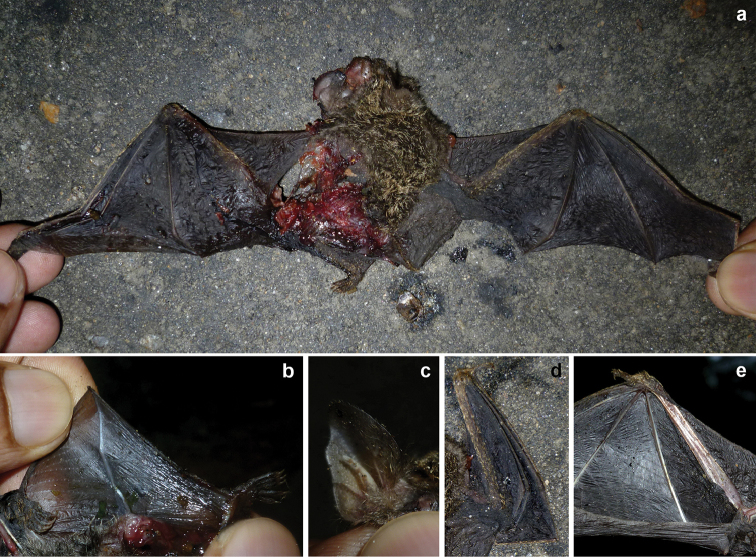
Road killed specimen of Phoniscuscf.jagorii with key characters a wingspan with the dorsal body color b Interfemoral membrane is well developed and semi–transparent (parts of the interfemoral membrane was damaged) c Long, tapering, notched tragus d forearm and digits covered with short, golden hair e ventral aspect of the wing.